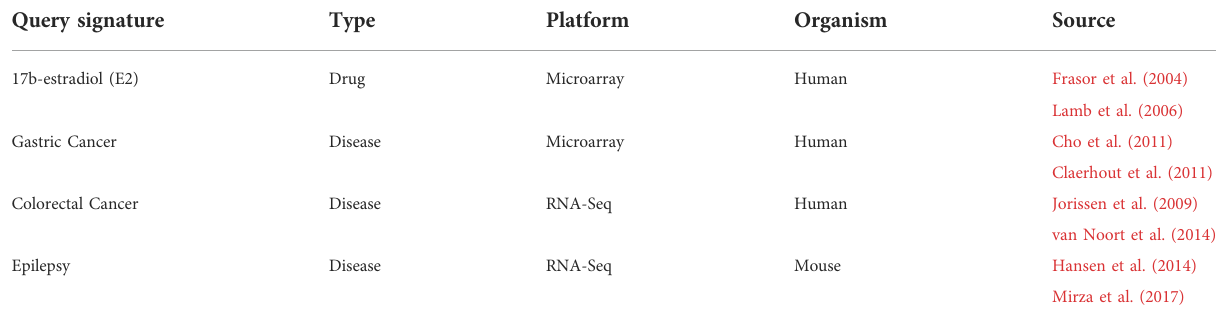
TABLE 1 Drug and disease signatures used to query LINCS drug signature database.